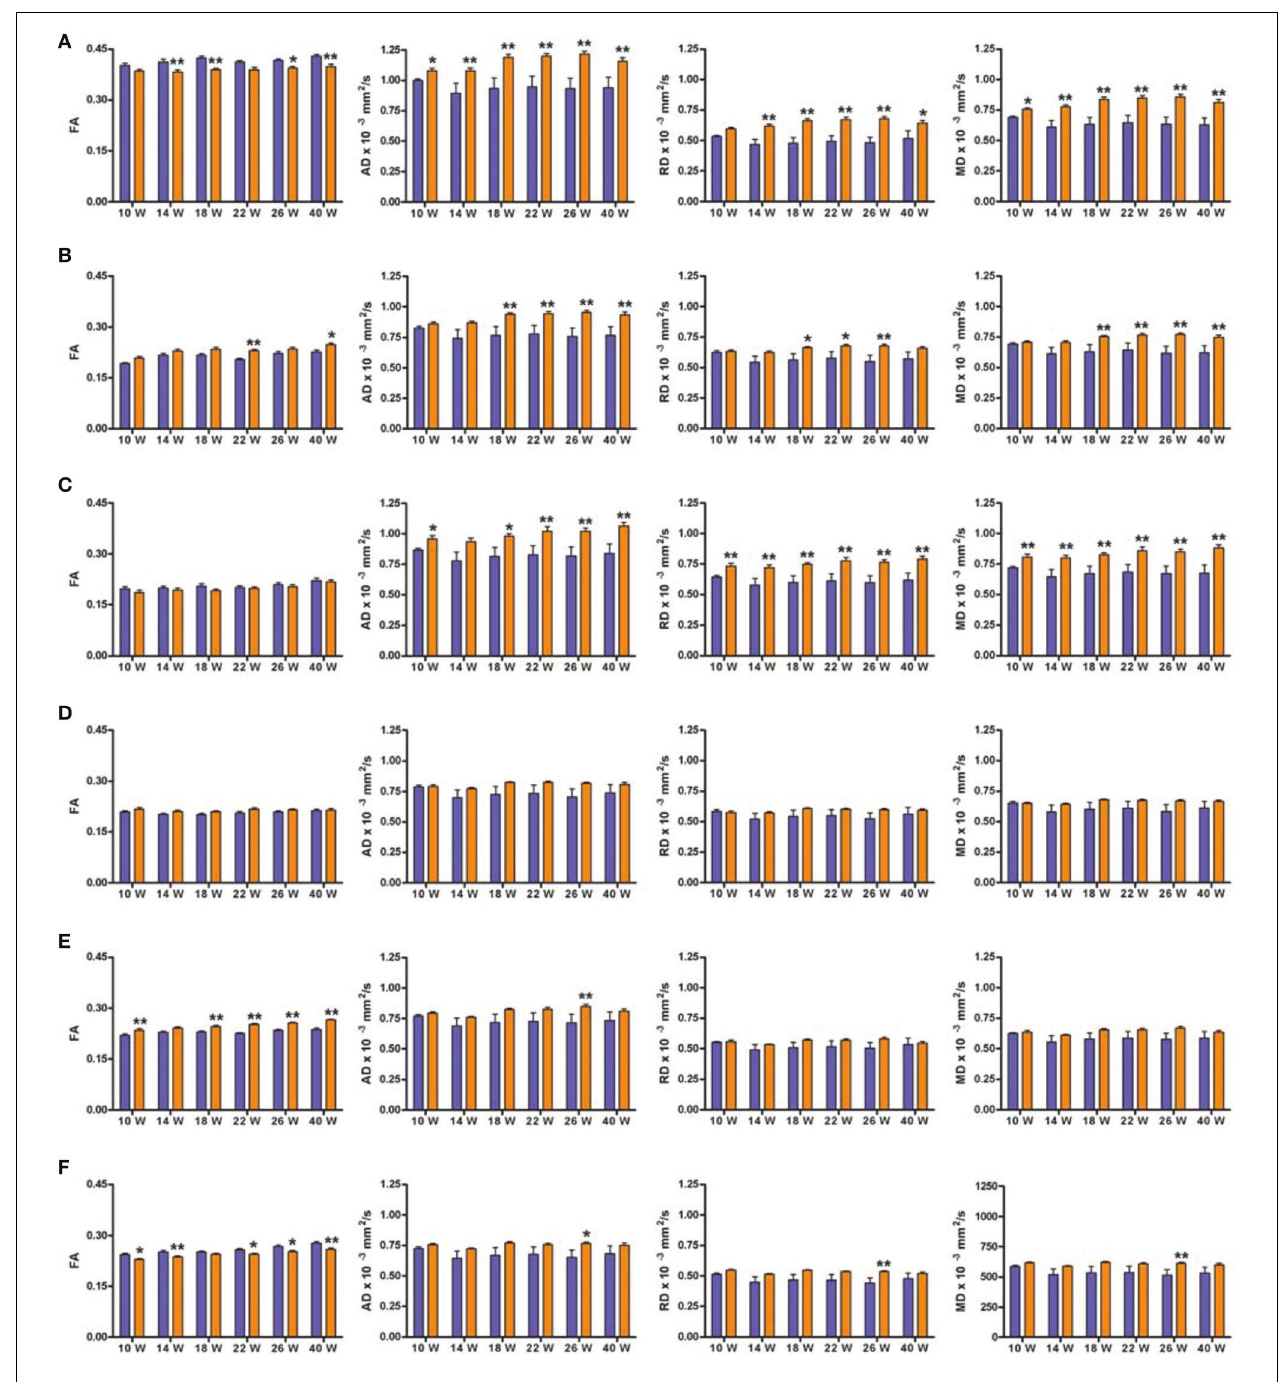
FIGURE 4 | DTI scalar map analysis. The four indices FA, AD, RD, and MD are indicated for each of the six structures analyzed at each of the six scanning time points. Blue bars represents control animals ( n = 11) and orange bars SHR group ( n = 12). (A) Corpus Callosum, (B) medial